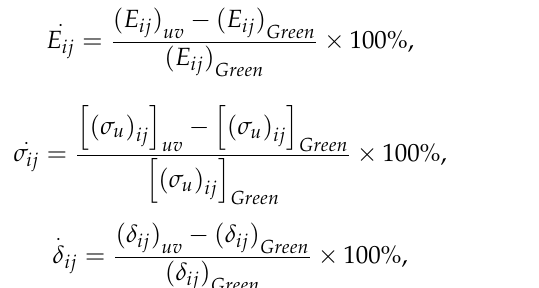
Table 5. The definition of number i and j of the change rate of the printing temperature and infill density respectively.